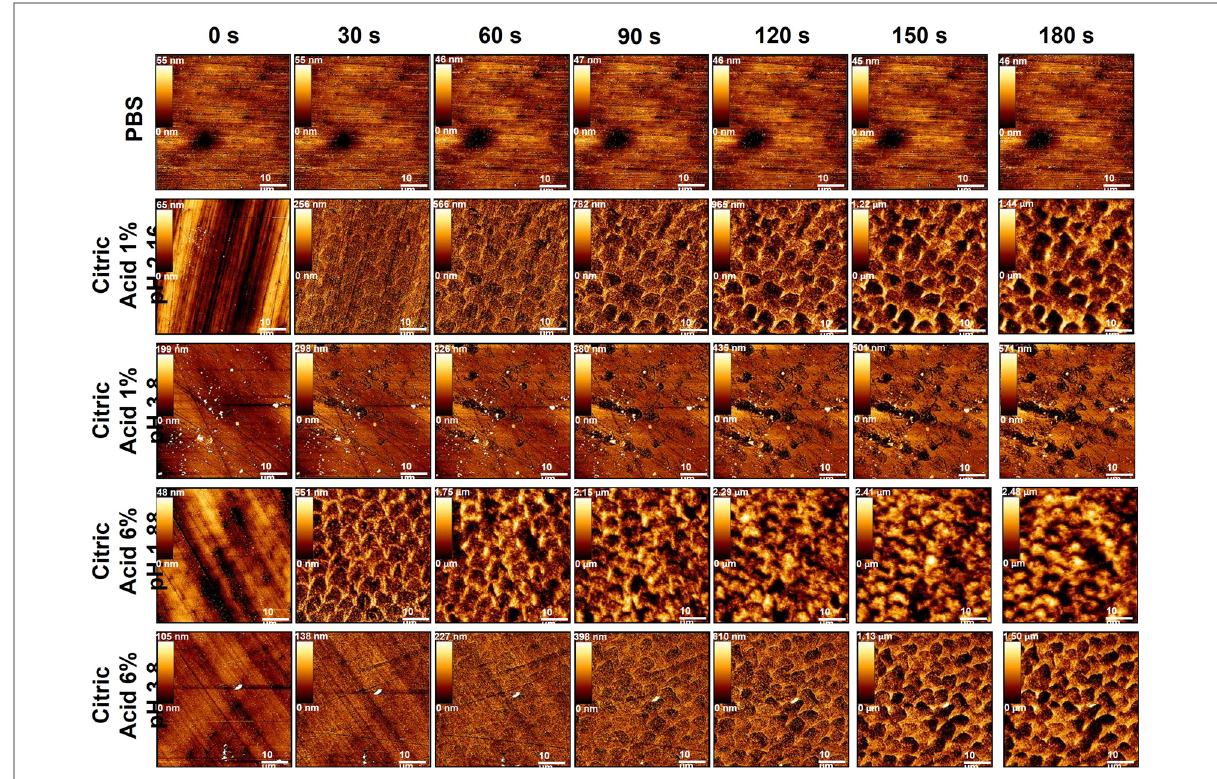
FIGURE 1 Showing example topographic AFM imaging of human enamel exposed to all dietary solutions (top) throughout the exposure regime starting from 0 s (top) to 180 s (bottom) at 30 s